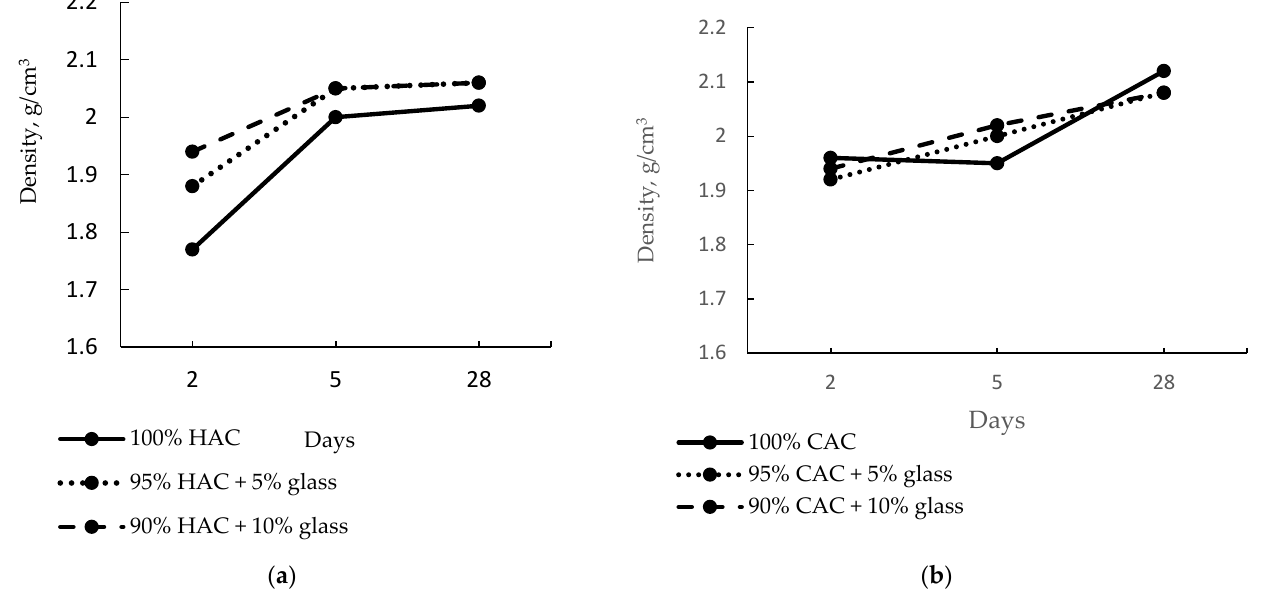
Figure 3. The density of pastes of HAC ( a ) and CAC ( b ) stored at 20 ◦ C. After five days of hardening, the density increased to 13% for the control paste sample and only 6% for the paste with 10% glass content, proving that the fine-ground glass accelerates the conversion process of HAC cement hydration products. Therefore, it shows a minor increase in density. However, after 28 days of hardening, no change was recorded in the pastes’ density containing 5% and 10% glass content. In the CAC case, the density of the control paste was higher than that of the HAC paste because the CAC hydrates faster